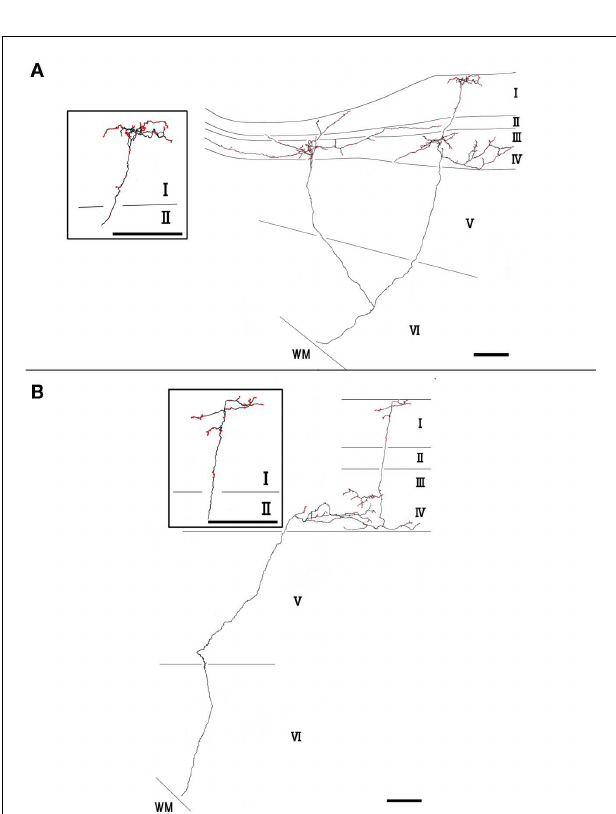
FIGURE 3 |Axon branches of type 2 (A,B). Conventions are the same as in Figure 2 . Scale bar, 100 μ m.